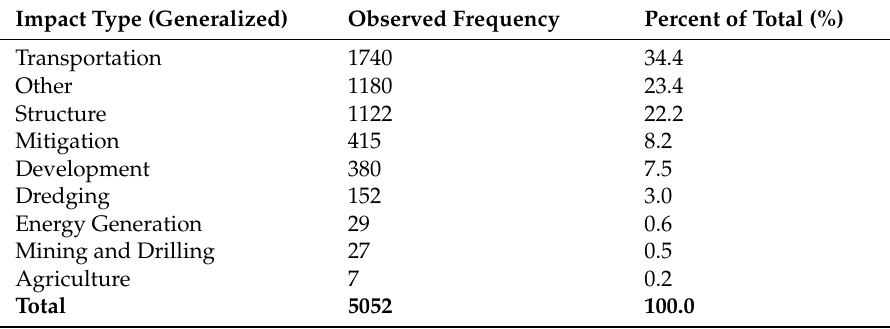
Table 6. Observed and relative frequencies of generalized impact types (2012–2017).